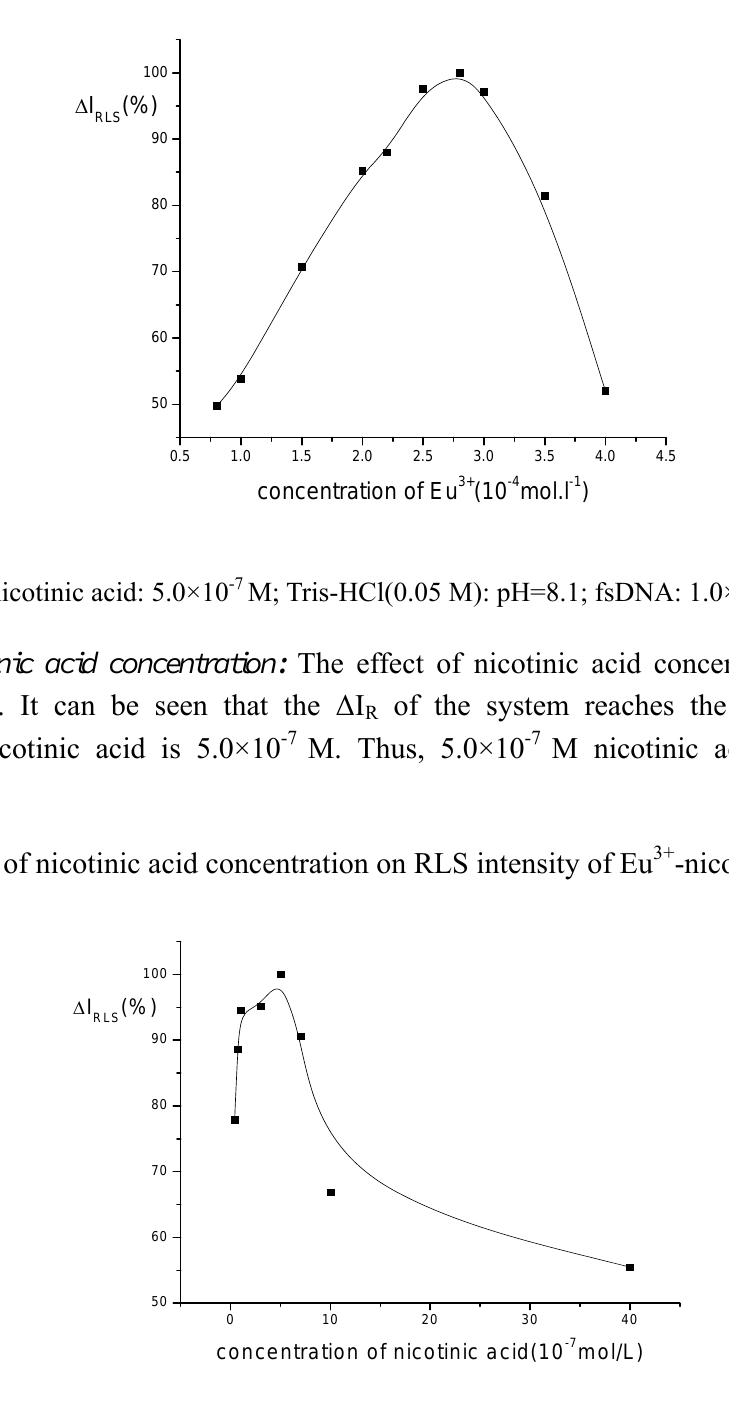
Figure 3 . Effect of Eu 3+ concentration on RLS intensity of Eu 3+ -nicotinic acid-fsDNA.